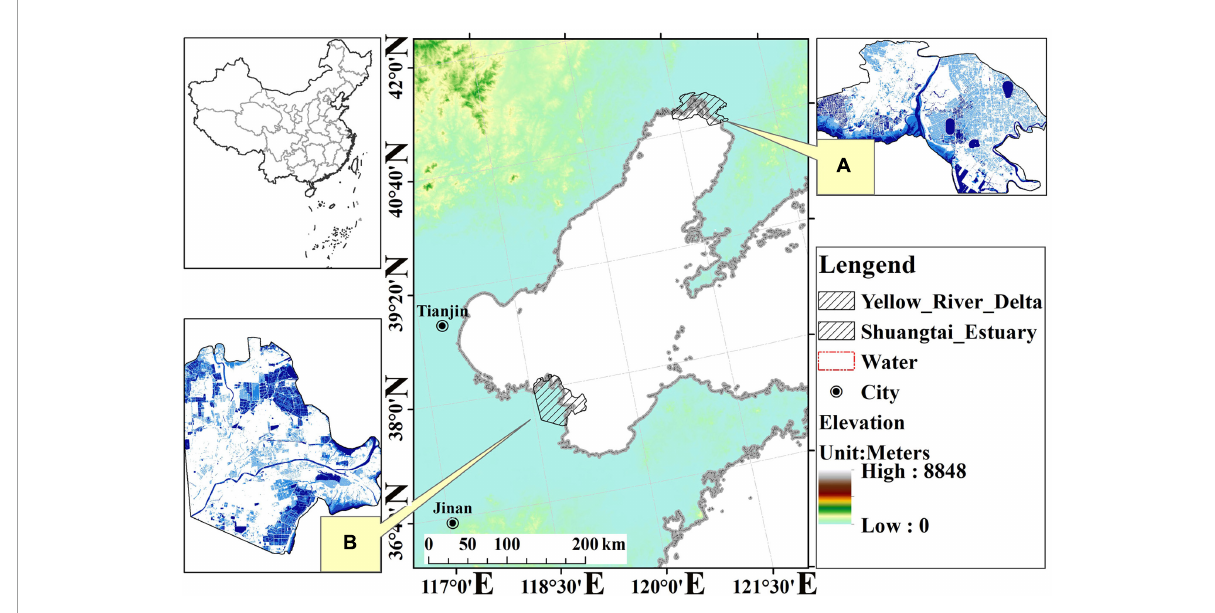
FIGURE1 Distribution of the study area: (A) Shuangtai River Estuary, and (B) Yellow River Delta.